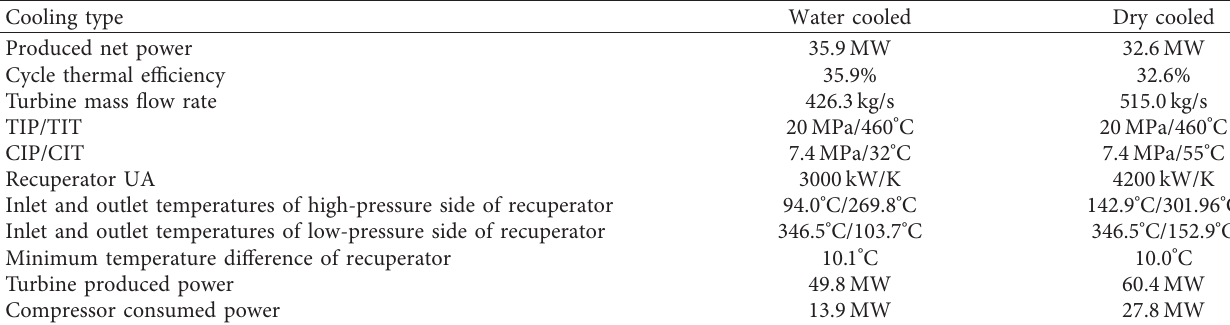
Table 5: Optimal design for the water-cooled simple Brayton cycle.